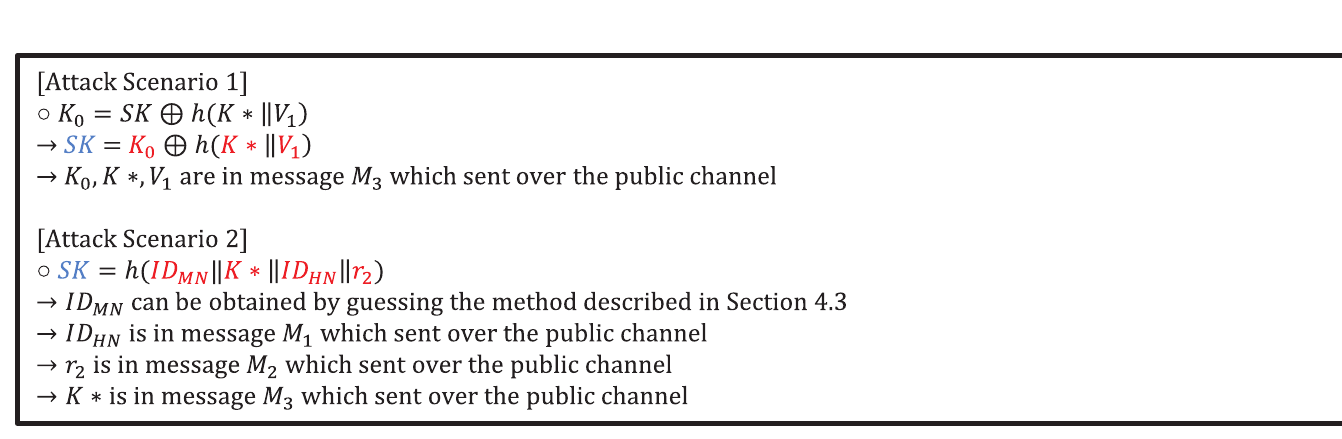
Fig 5. Session key derived attack in Ahmed et al.’s